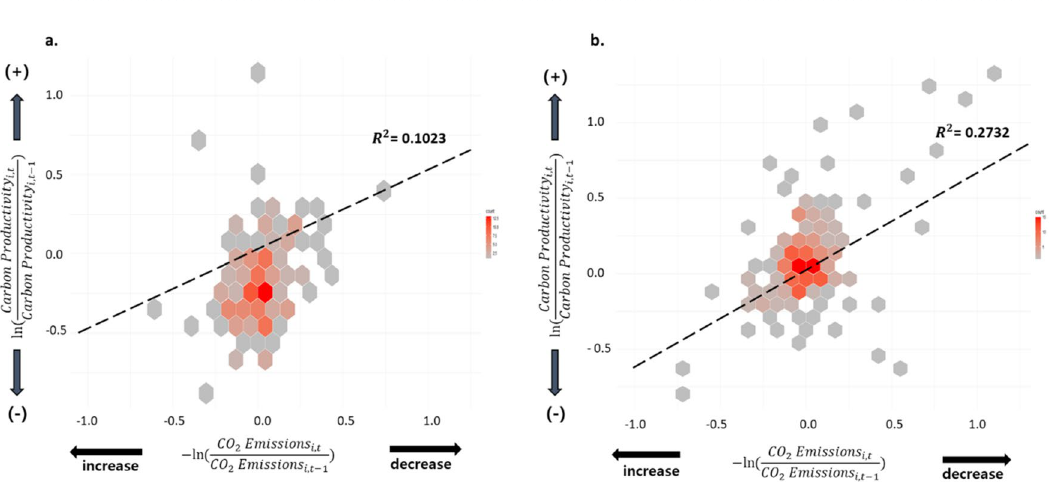
Figure 2. Heatmaps of sample firms’ carbon productivity change by emission level. ( a ) Before ETS to ETS Phase 1. ( b ) ETS Phase 1 to ETS Phase 2. Color scale indicates the number of firms per